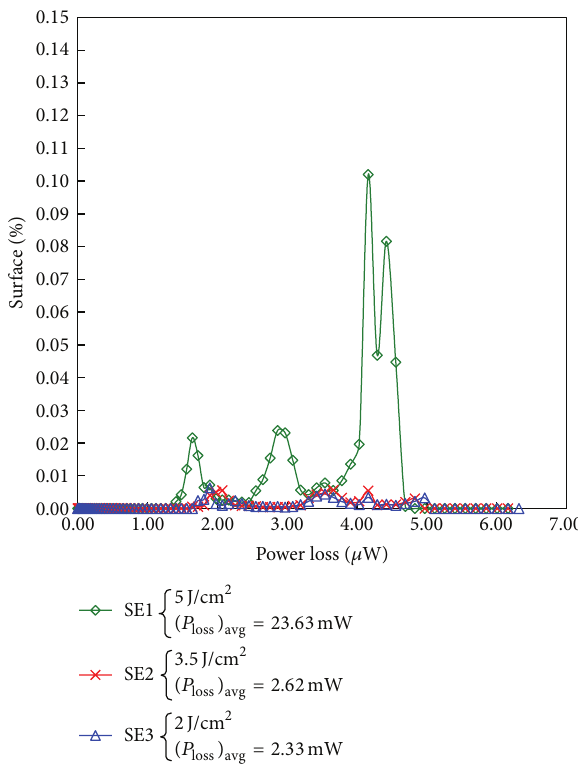
Figure 7: Comparison of distribution profile and average value of power loss (in mW/cm 2 ) for SE mc-Si solar cells with different laser